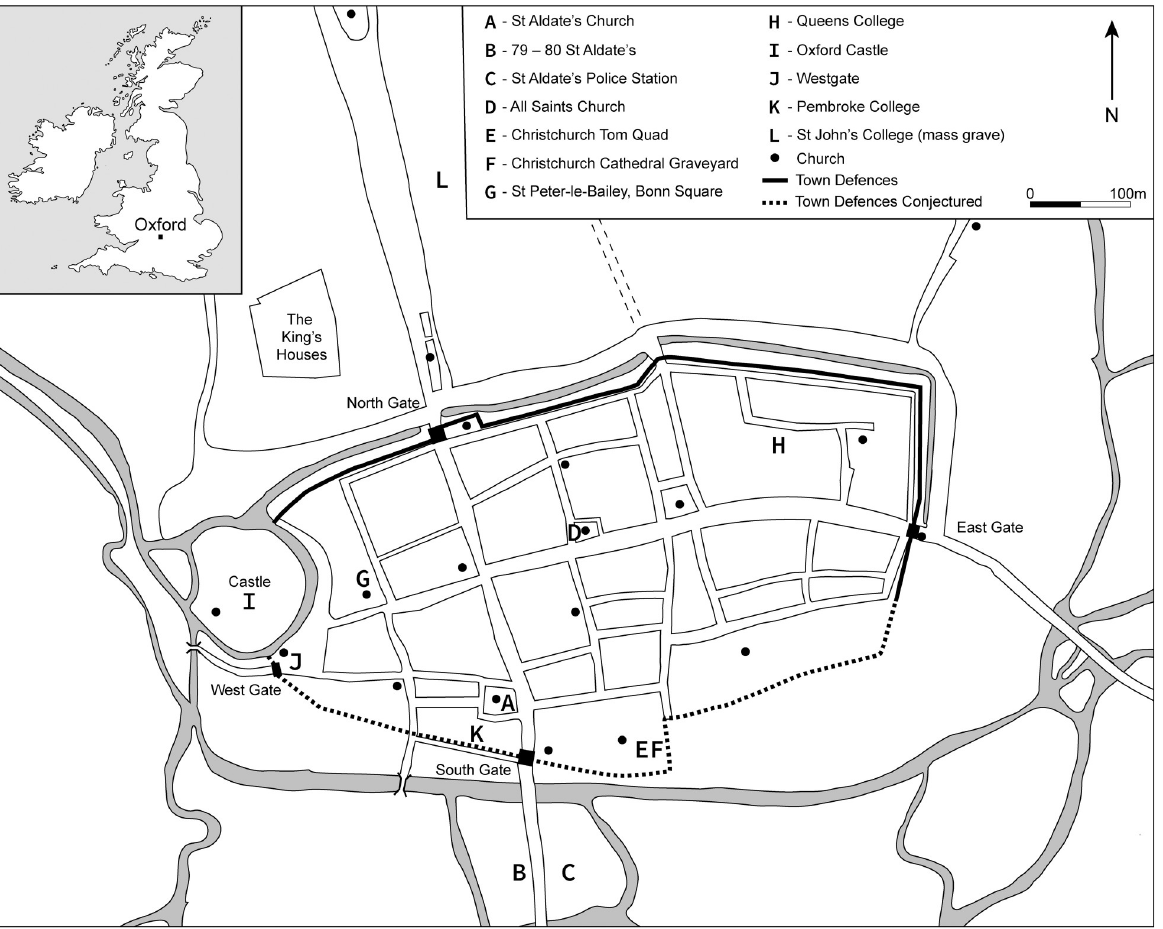
Fig 1. Plan of medieval Oxford showing the sites included in the present study. St John’s College (L) is included in this study as comparative data only.